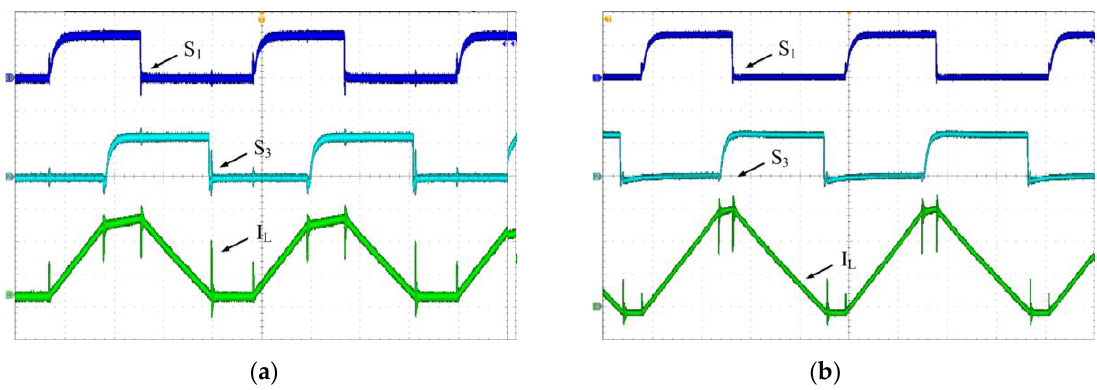
Figure 18. Measured waveforms using different control methods (250 W). ( a ) Proposed APS control method (99°); ( b ) Fixed phase-shift value (148°). (CH1: 10 V/div, CH2: 10 V/div, CH4: 1 A/div, Time: 8 μs/div).